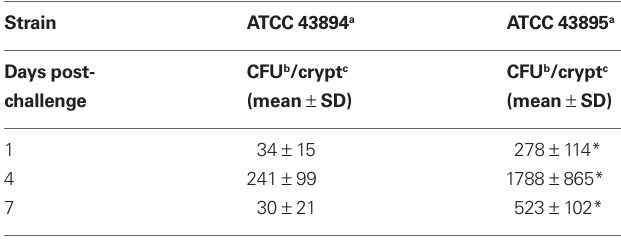
Table 2 | Escherichia coli O157:H7 from bovine rectal tissue